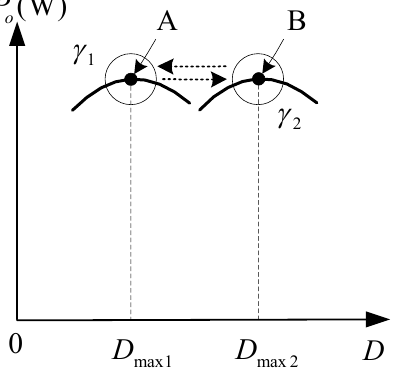
Figure 8. Regularity under (4) or (6) conditions.